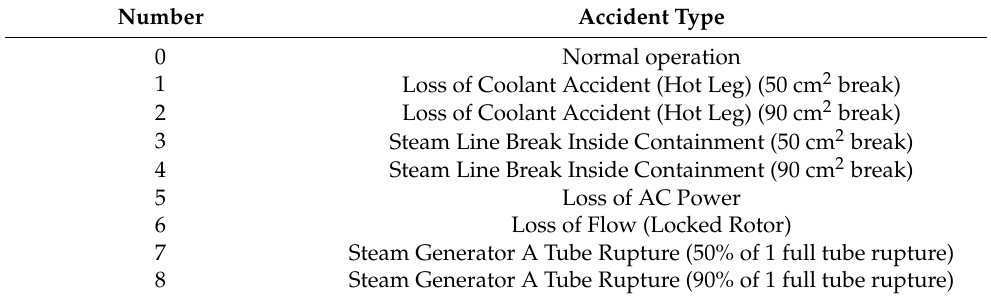
Table 6. Number of Accident Conditions.